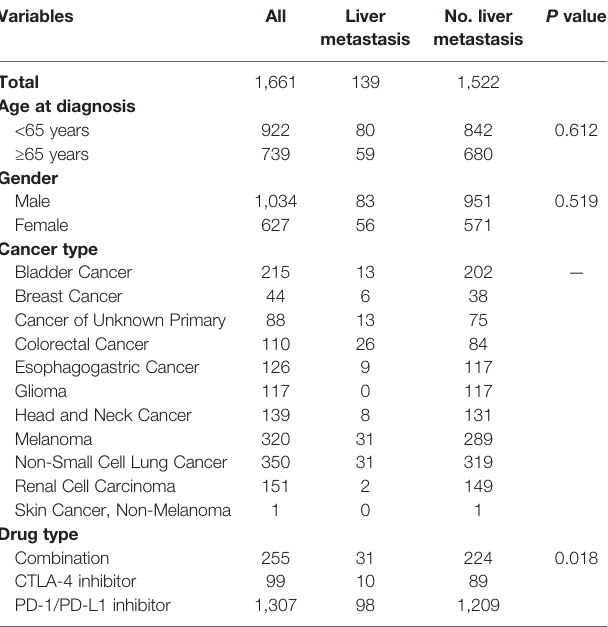
TABLE 1 | Baseline characteristics of the study